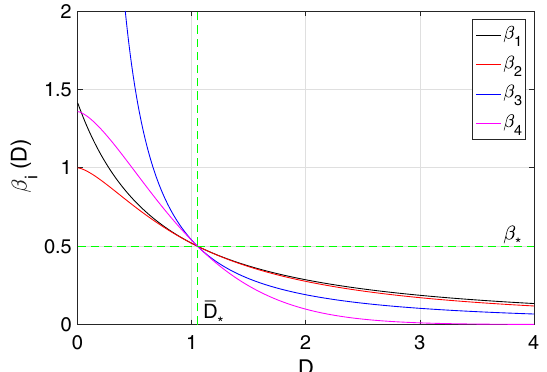
Figure 1. The different transmission rate functional forms β i ( D ) , i = 1, 2, 3, 4 are pictured. The scaling distance was taken to be ¯ D ∗ = 1.05 for all transmission rates, which was considered to be an average of the distance types D_* from Table 1. The other parameters were chosen to be β ∗ = 0.5 and ν = 1.5 .